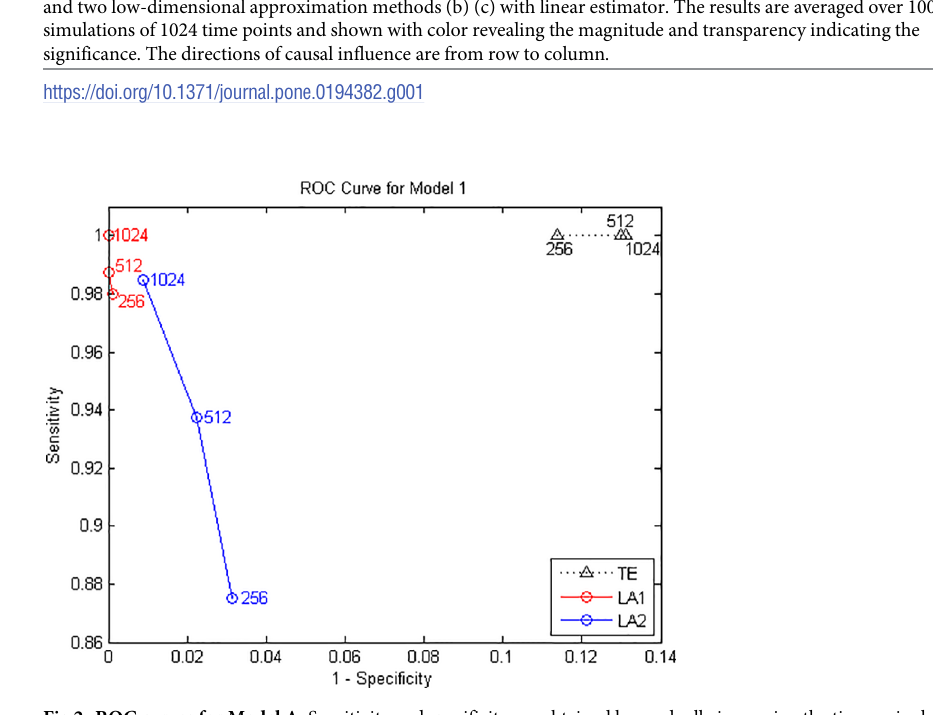
Fig 2. ROC curves for Model A. Sensitivity and specificity are obtained by gradually increasing the time series length from 256 to 1024 points.